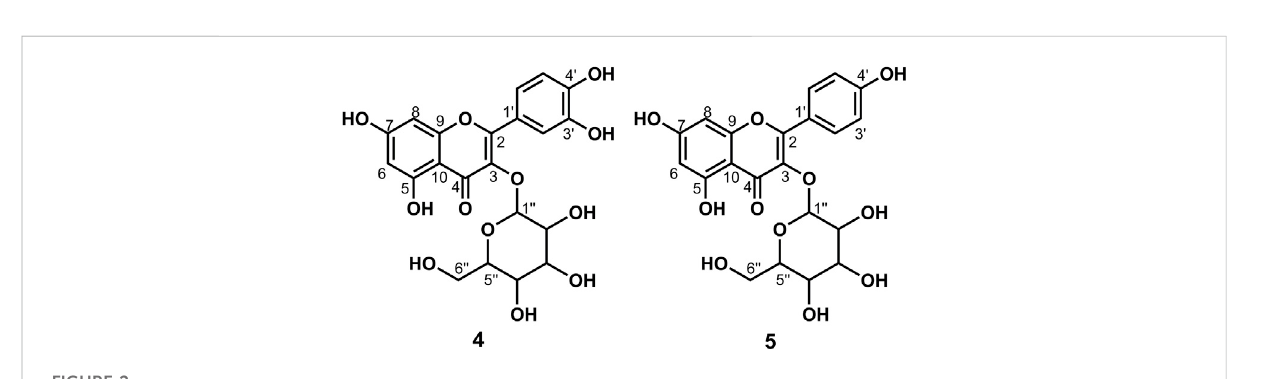
FIGURE 2 Chemical structure of compounds 4 and